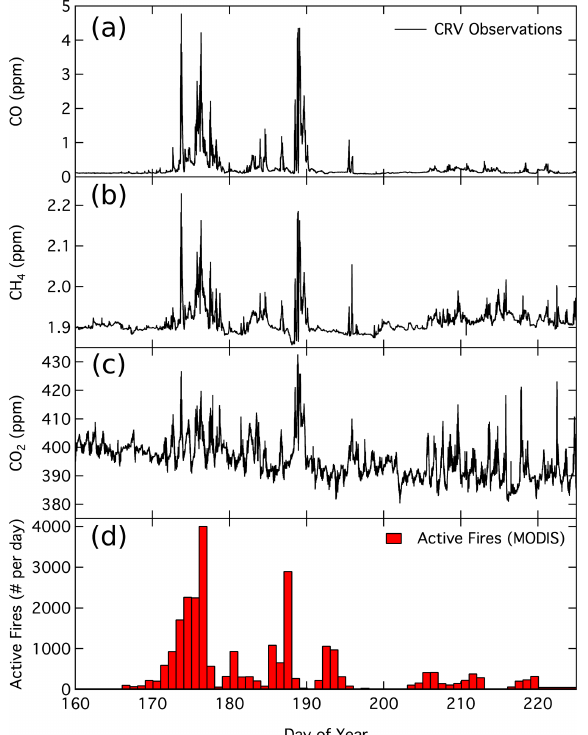
Figure 5. CRV tower observations of (a) CO, (b) CH 4 , and (c) CO 2 are shown along with intervals used to calculate emission ratios (shown in color). The primary combustion process is noted with blue for smoldering, purple for mixed, and red for flaming. The trace gas observations are shown at a 30s temporal